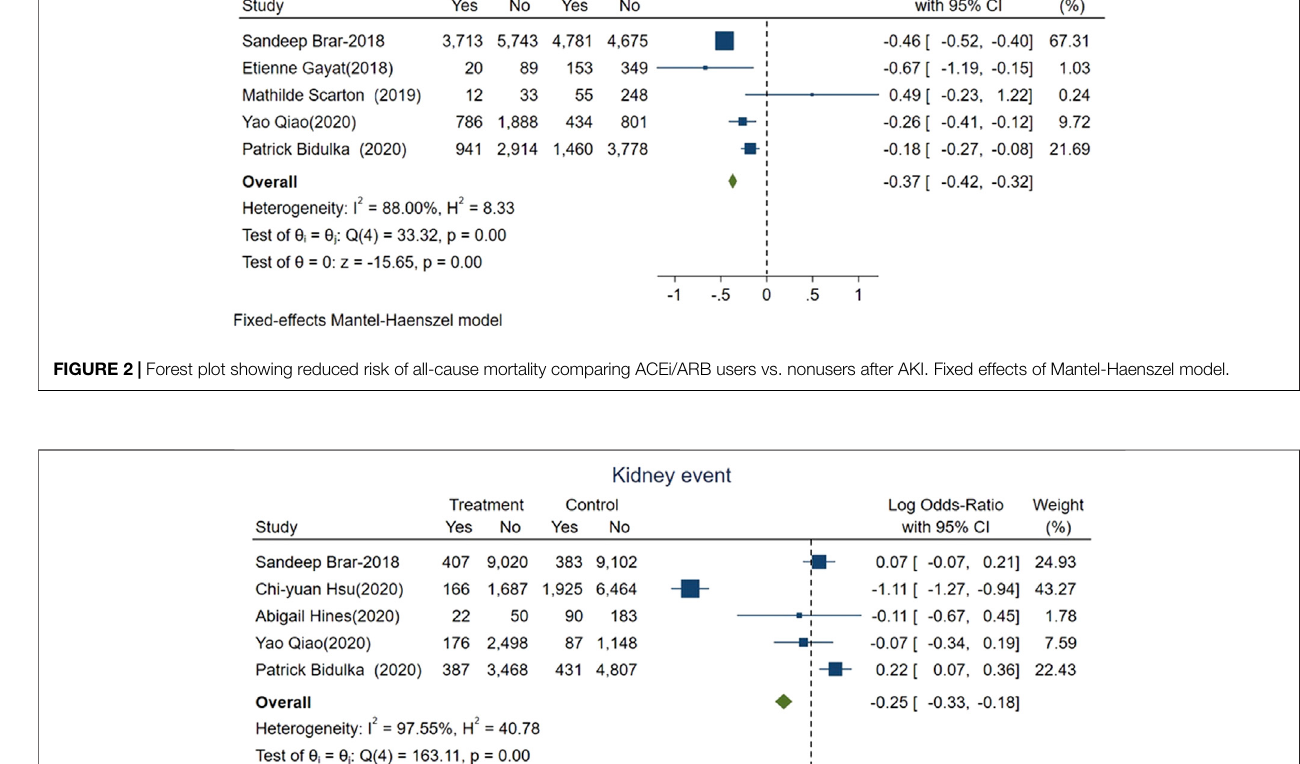
Meta-Regression Analysis Increased percentages of congestive heart failure (CHF) and diabetes were associated with attenuated logOR for all-cause mortality between exposed and control groups (Z (cid:2) 3.31; p (cid:2) Supplementary Figure S5B , respectively). Increased